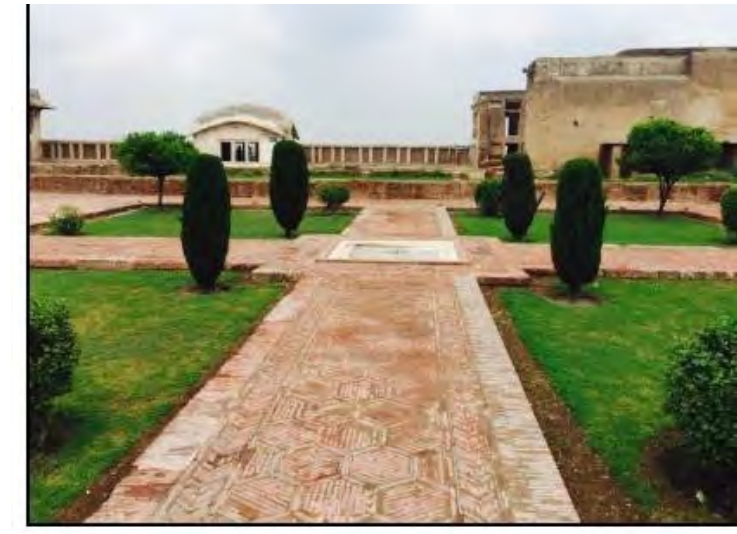
Figure 10. A view of fountain in Paien bagh quadrangle